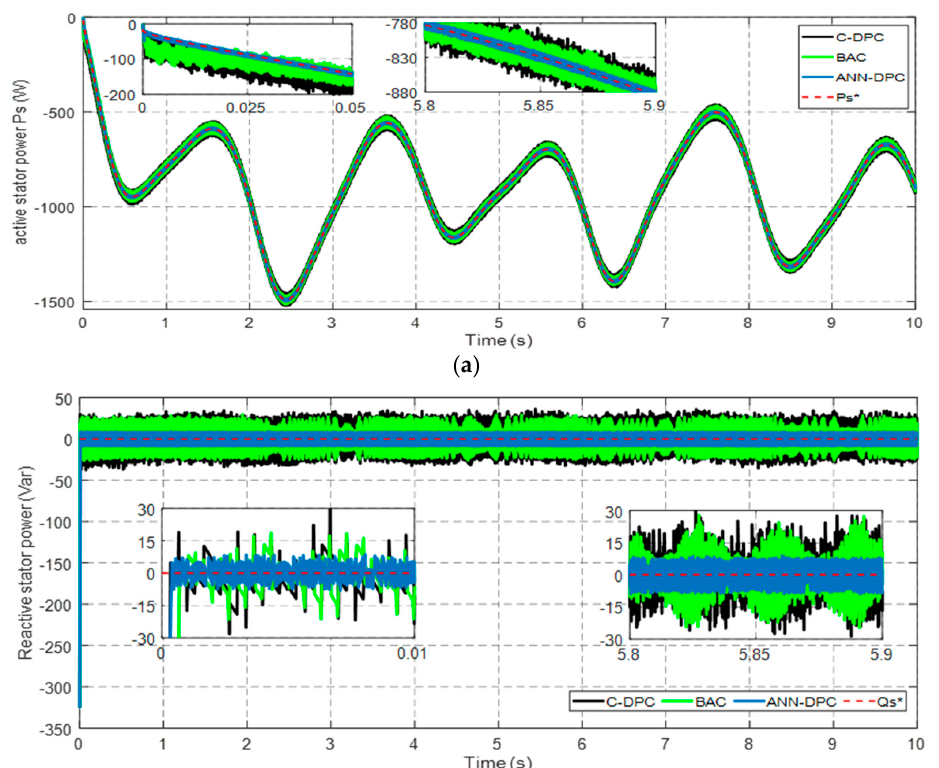
Figure 16. Power, ( a ) Ps , ( b ) Qs.